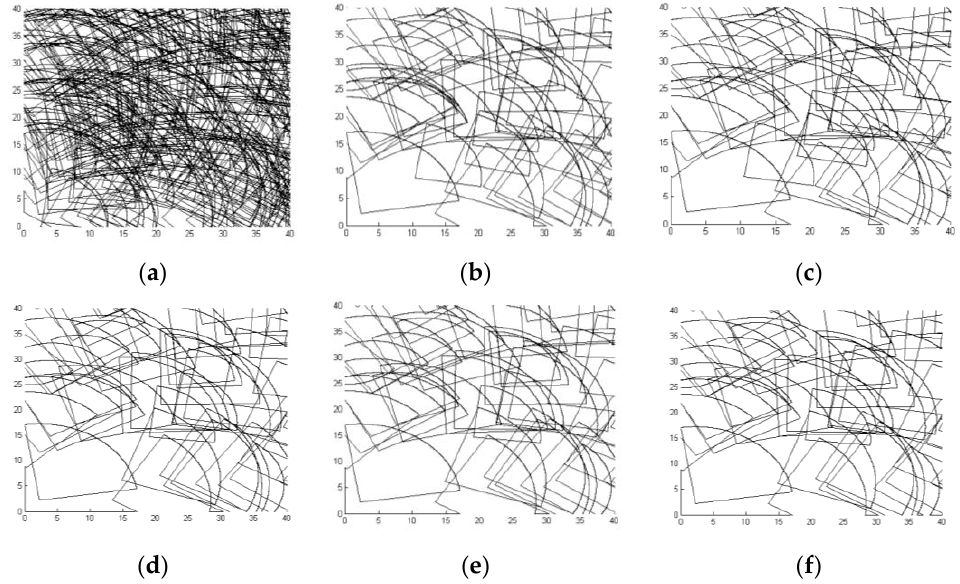
Figure 4. One of the non-dominated solutions. ( a ) 300 nodes, initial distribution; ( b ) the 100th generation, 66 nodes, 89.3% coverage rate, full connect value; ( c ) the 200th generation, 62 nodes, 90.9% coverage rate, full connect value; ( d ) the 400th generation, 58 nodes, 91.3% coverage rate, full connect value; ( e ) the 600th generation, 57 nodes, 92.9% coverage rate, full connect value; ( f ) the 800th generation, 53 nodes, 95.8% coverage rate, full connect value.